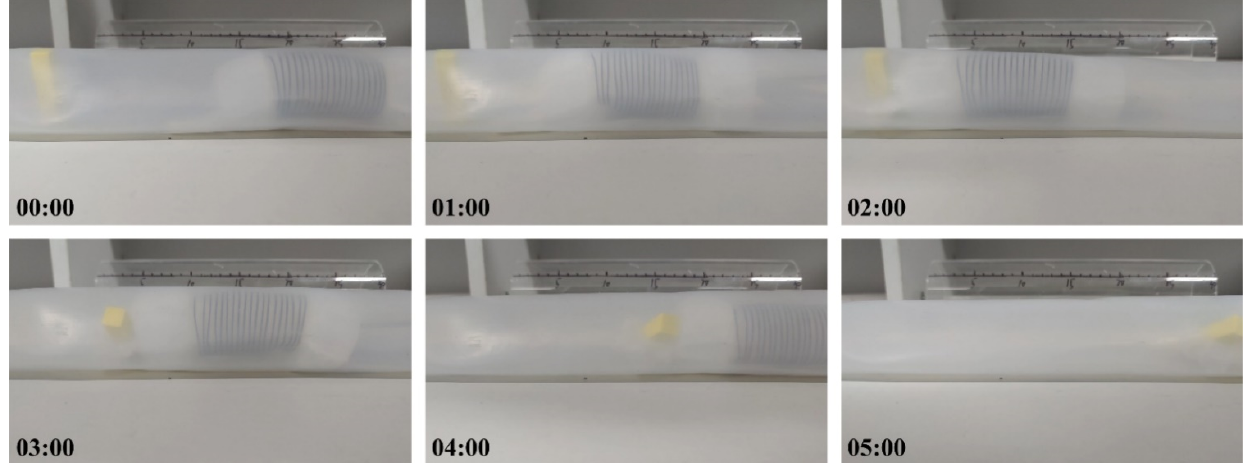
Figure 8. The intestinal soft robot performs moving and extracting tasks in a flexible tube. (The number represents the running time of the soft robot.)